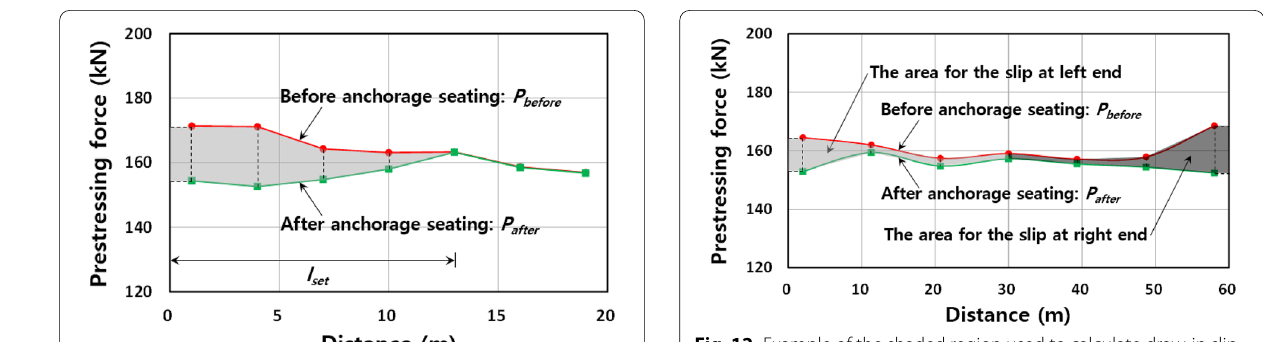
Fig. 12 Example of the shaded region used to calculate draw‑in slip (girder 2 of bridge B). Table 3 Draw‑in slips at anchorages in full‑scale specimen.